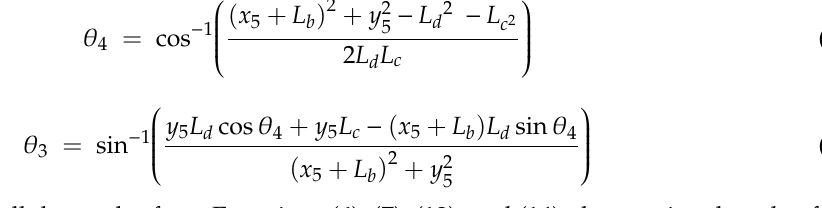
Table 2. Variables of the VGV mechanistic model.